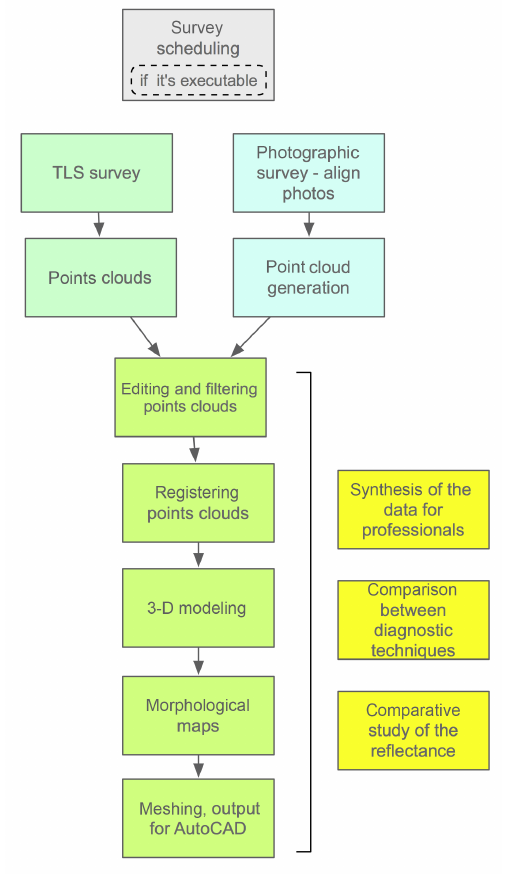
Figure 3. Flow chart of TLS and Photogrammetry data acquisition and processing.